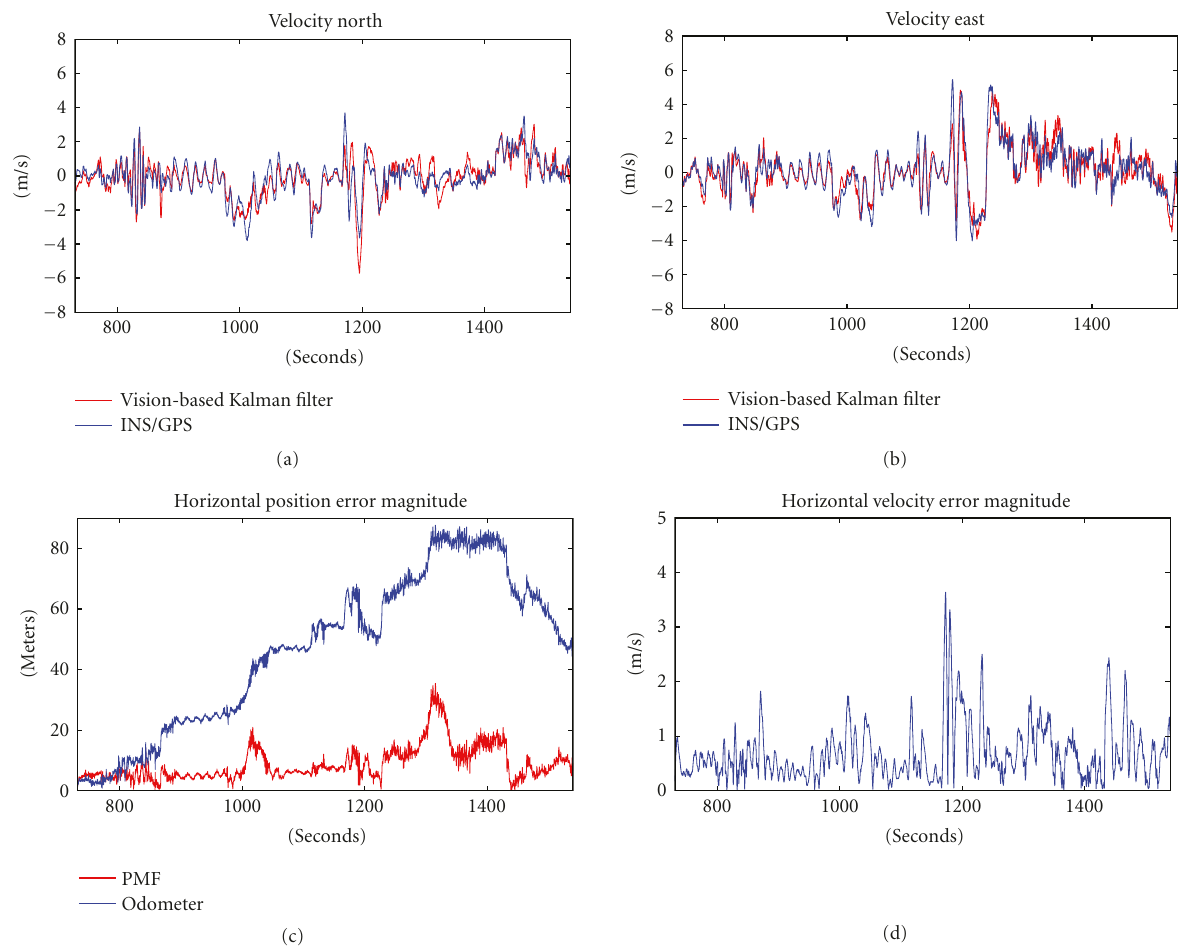
Figure 16: Real-time on-board results. (a) and (b) show the north and east velocity components estimated by the Kalman filter while (d) displays the horizontal velocity error magnitude. In (c) the position error comparison between PMF and odometry is given.